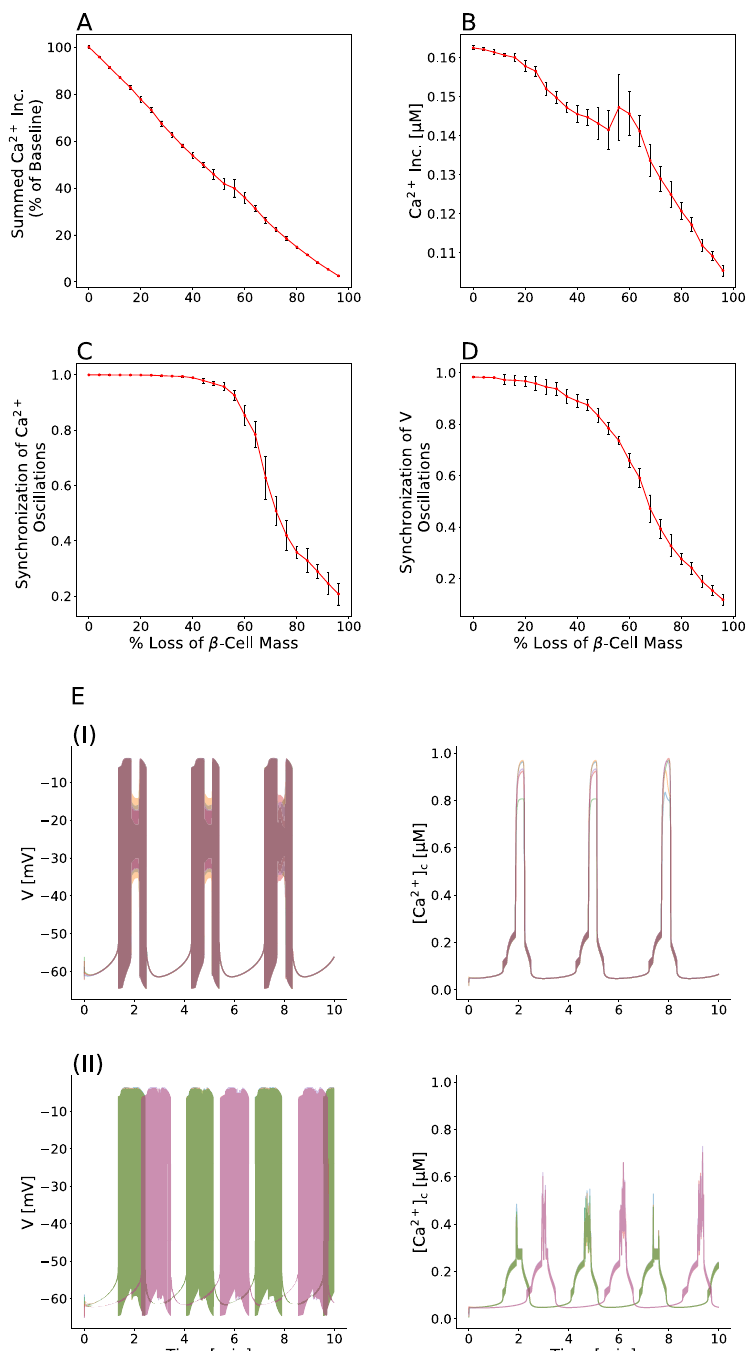
Figure 1. Loss of β - cell mass causes defect of β -cell function. ( A ) Linear decrease in the summed [ Ca 2 + ] c activity during reduction of β -cell mass. The number of cells reduced is represented as the % of all cells in the modeled islet (1000 cells). ( B ) Mean [ Ca 2 + ] c activity during reduction of β -cell mass. Note that deficiency in β -cell mass has the strong effect on [ Ca 2 + ] c level. ( C , D ) Dependence of the synchronization of [ Ca 2 + ] c and membrane potential oscillations as a function of the number of cells reduced ( % of islet). The intra-islet synchronization is disrupted after loss of ∼ 50% β -cell mass. ( E ) Representative simulated membrane potential and [ Ca 2 + ] c time-courses across the islet lacking 10% β -cells (subpanel (I)) and lacking 80% β -cells (subpanel (II)). A massive decline in β -cell mass causes changes in the shape of electrical bursting. Data in ( A – D ) represent the mean ± S.E.M. over 10 modeled